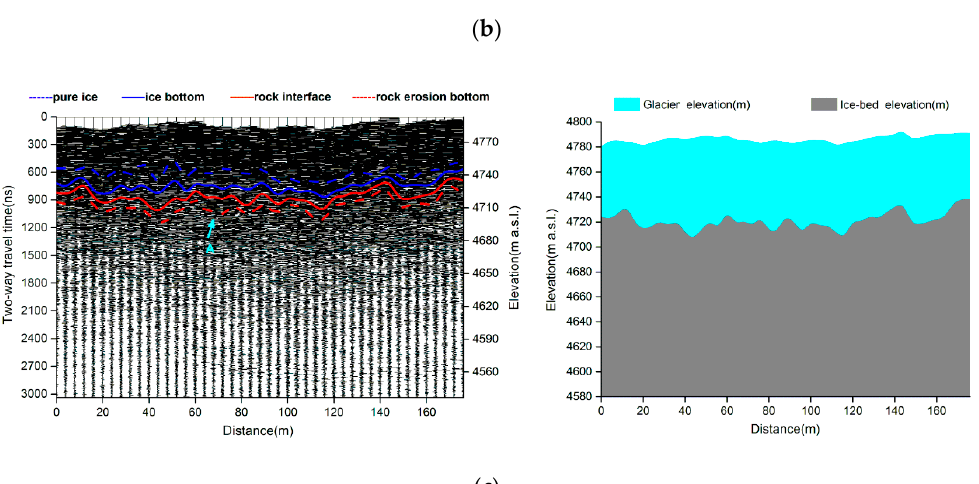
Figure 4b. The wave polarity changed between − + − and + − + at 620–781.2 ns (48.3–60.9 m, position 3 ′ –3), with an amplitude peak of 200 Hz, which is inferred as the debris-rich ice layer. The reflected wave amplitude changed from 100 Hz to 50 Hz at 781.2 ns (60.9 m, position 3), and the polarity changed to + − +, with an amplitude that, again, increased to 100 Hz at 868 ns (67.7 m, position 4 ‴ ). The amplitude characteristics of the position between 781.2 and 868 ns (60.9–67.7 m, position 3–4 ‴ ) can be considered a subglacial till layer ( ɛ = 7–9), containing dry sandy gravel and rock debris. The ice thickness of the measuring point B of profile T2 was 60.9 m (781.2 ns, position 3), and the bedrock interface was at about 67.7 m (868 ns, position 4 ‴ ). The wave polarity altered to + − + and the amplitude increased to 150 Hz at 942.4 ns (73.5 m), which can be considered as pellicular water ( ɛ = 80), and the amplitude reduced to 20 Hz below 979.6 ns (76.4 m, position 4), with no apparent changes. We considered that the depth of meltwater eroded the limestone between 868 and 979.6 ns (67.7–76.4 m, position 4 ‴ –4), which was generated from water seepage down the surface fissures of